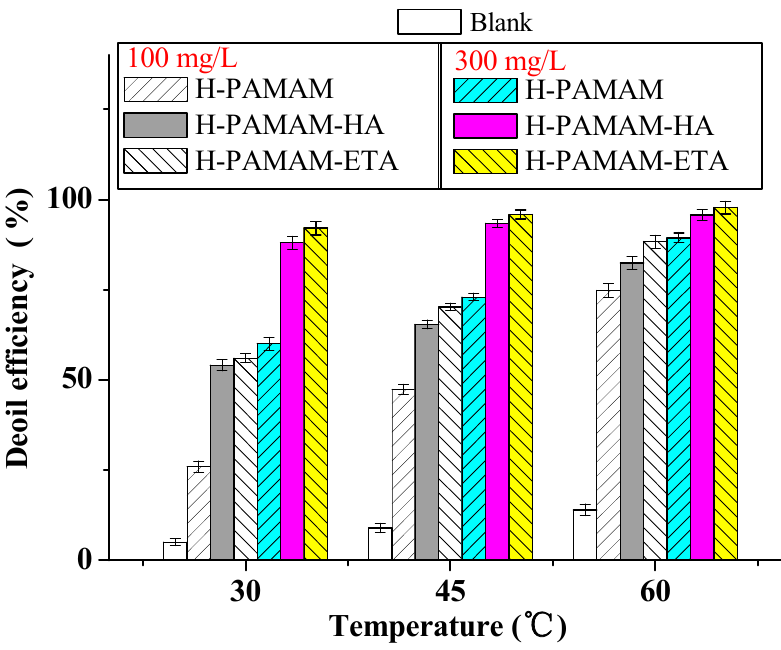
Figure 3. The changes in the deoil efficiency versus temperature with 100 and 300 mg/L demulsifier concentrations with settling times of 30 min, respectively.